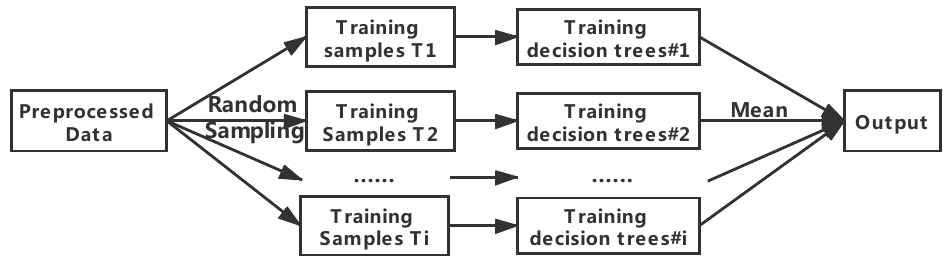
Figure 3. The training process of random